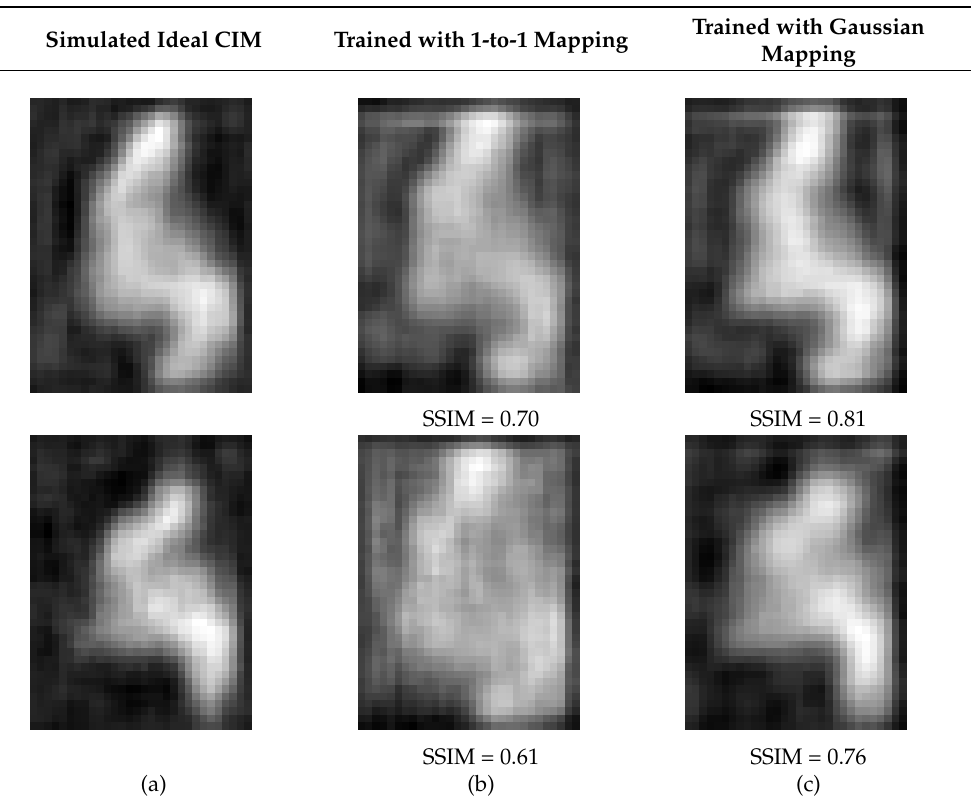
Table 5. SRCNN Results when conducting only the first layer on